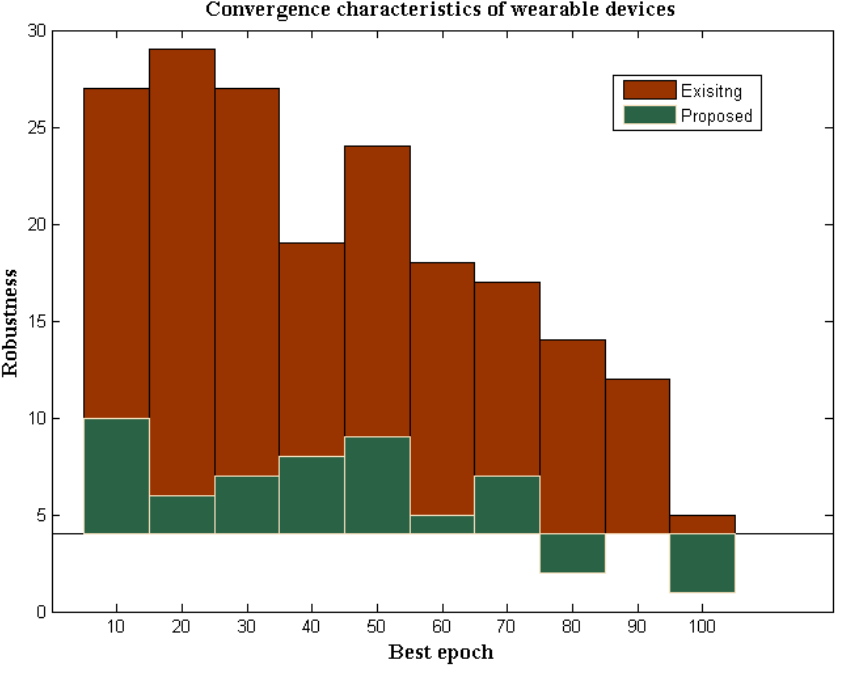
Figure 8. Robustness characteristics.